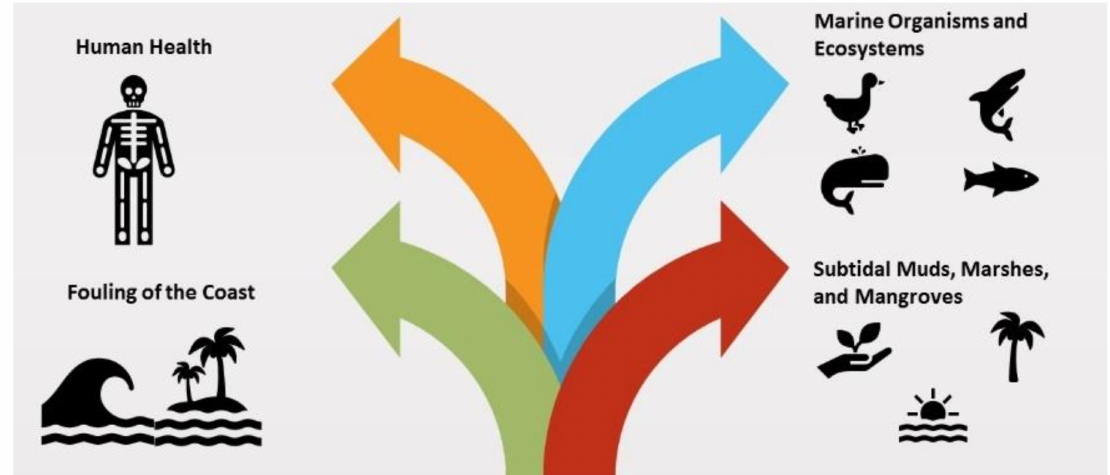
Figure 3. Few impacts of oil spills in the marine environment.